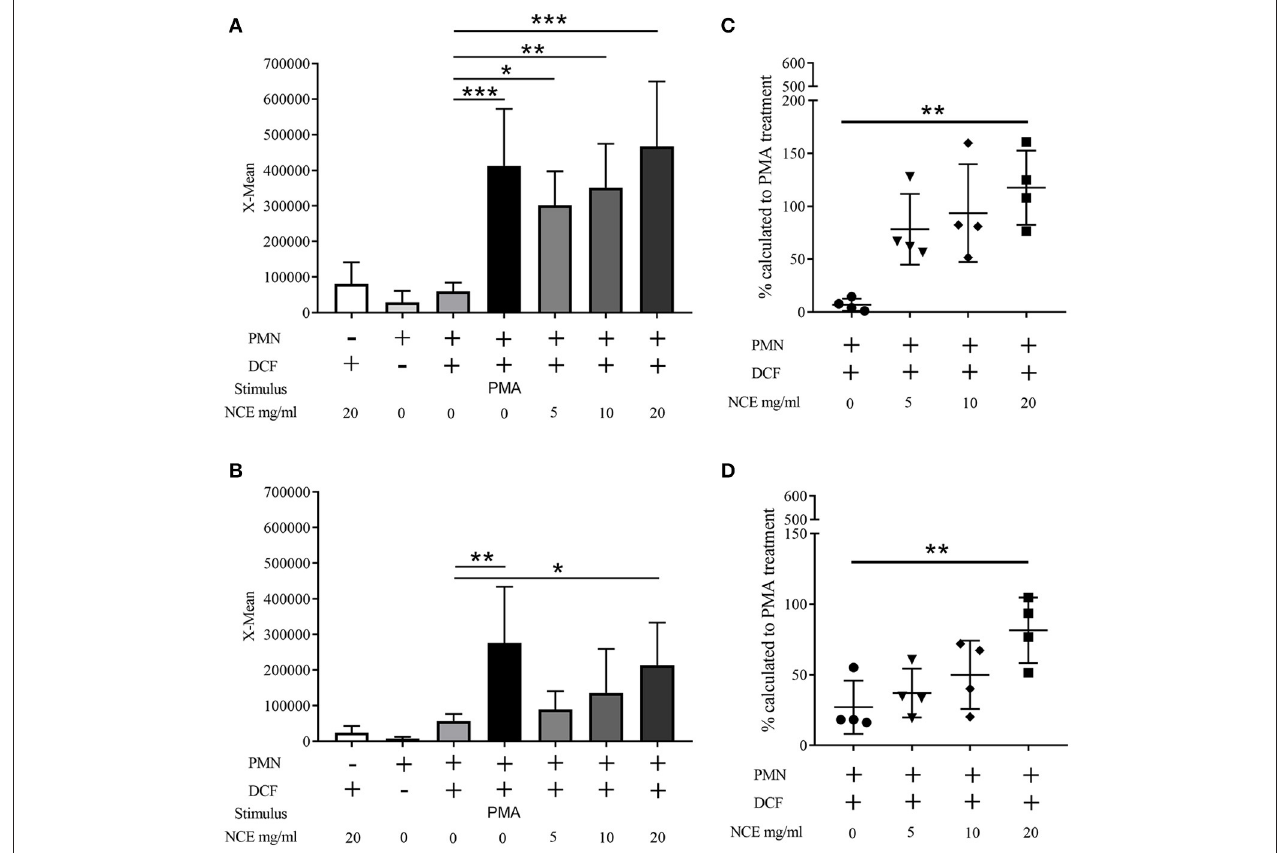
FIGURE 5 | Effect of natural crude extract (NCE) on oxidative burst (ROS production) of human and bovine granulocytes. Mean fluorescence intensity (X-mean) of ROS was measured by FACS (BL-1) using DCF fluorescence probe ( n = 4). Phorbol 12-myristate 13-acetate (PMA) was used as a positive control to induce ROS production. NCE significantly induces ROS production in human granulocytes (A) and bovine granulocytes (B) compared to unstimulated cells (cell + DCF). Additionally, the relative value to the PMA-stimulated cells was calculated and is presented as percentage (C,D) . Each dot represents one experiment. All data are shown as means ± SD. Statistical analysis was conducted with one-way ANOVA repeated measurement followed by Dunnett’s multiple comparisons test (A,B) or in the case of non-normal distributed data by Friedman multiple comparisons test (C,D) to unstimulated cells. * P < 0.05, ** P < 0.01, and *** P < 0.001 were considered